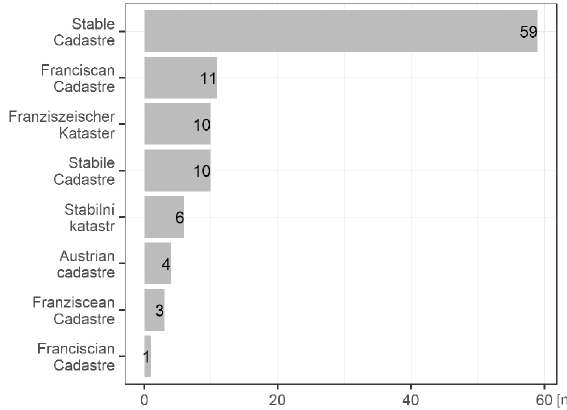
Fig. 2. Terms used for retrieval of the